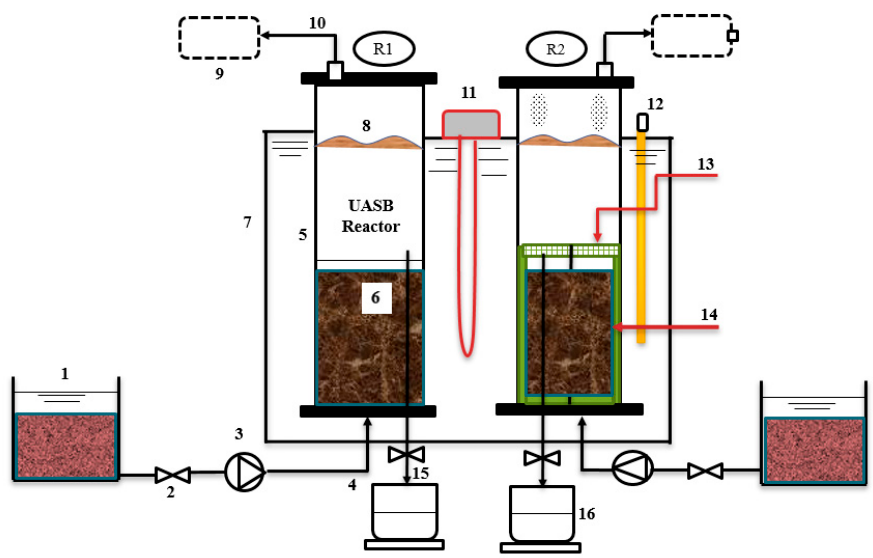
Figure 1. Schematic diagram of the upflow anaerobic sludge blanket (UASB) reactors sector: ( 1 ) Substrate, ( 2 ) open and close valve, ( 3 ) dosing pump, ( 4 ) influent, ( 5 ) PVC UASB reactor, ( 6 ) sludge, ( 7 ) water bath, ( 8 ) substrate level, ( 9 ) Tedlar bag, ( 10 ) biogas outlet, ( 11 ) heater, ( 12 ) thermometer, ( 13 ) PVC mesh coupled synthetic grass, ( 14 ) synthetic grass as attached growth, ( 15 ) effluent outlet, and ( 16 ) outlet container.